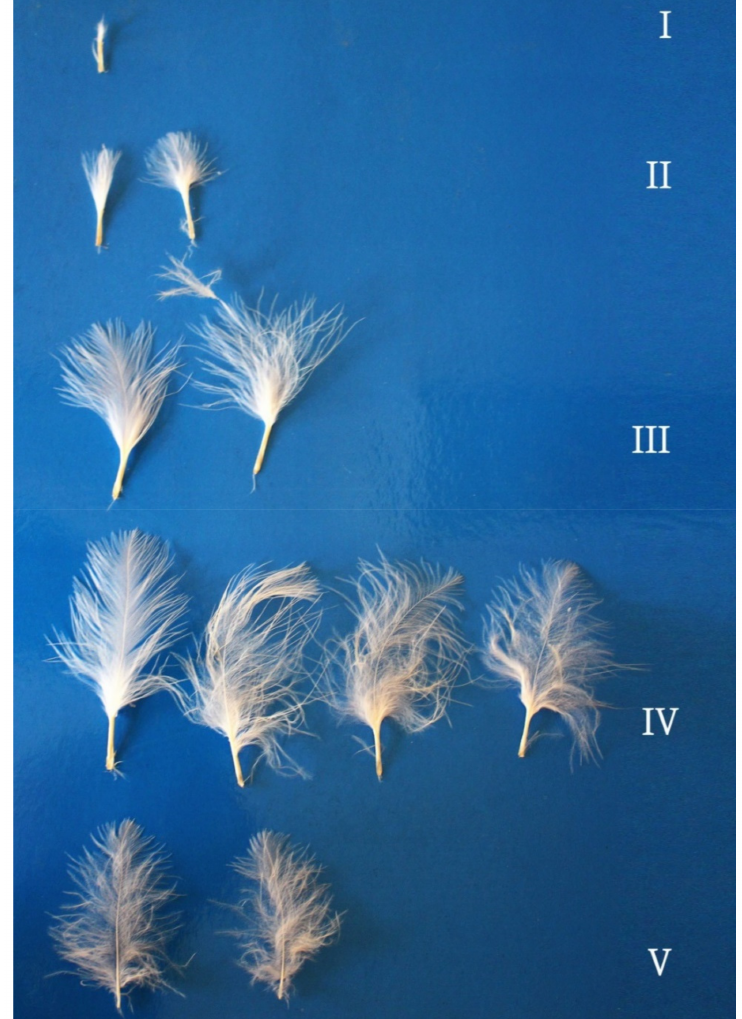
Figure 1. Thigh feathers of a 4-week-old turkey. Feather growth stages: I—pinfeather covered in sheath; II– barbs protruding from the sheath; III—plumulaceous (loose) vane (thigh), pennaceous (coherent) vane (interscapular region), feathers unsheathed by 1 / 2 of rachis length; IV—plumulaceous (loose) vane (thigh), pennaceous (coherent) vane (interscapular region), feathers unsheathed by 3 / 4 of rachis length; V—mature feathers, feather length: shortest—2.5 cm, longest—3.0 cm, absence of afterfeathers and empty spaces between